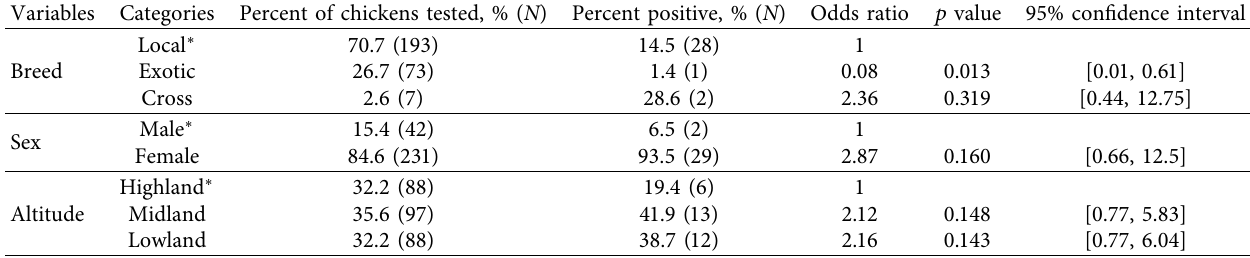
Table 2: Univariable logistic regression output of host-related and environmental risk factors and their odds of exposure of chickens to avian tuberculosis.